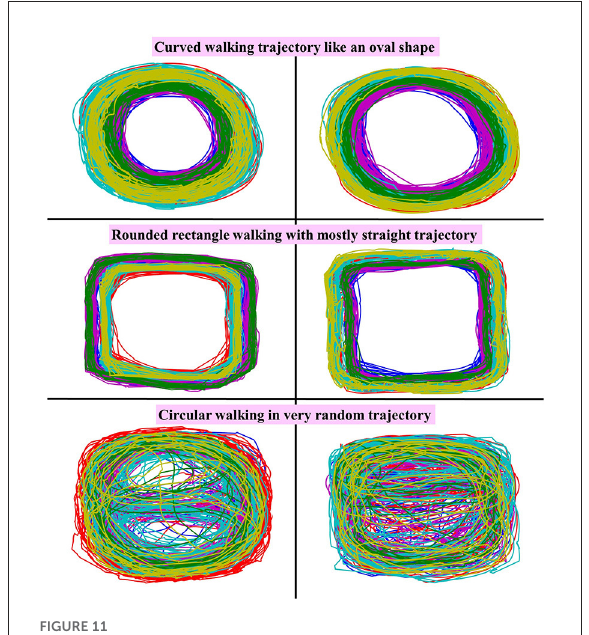
FIGURE11 Sample of walking path from six subjects in this dataset, including oval-shaped walking, rounded-rectangular walking, and random circular